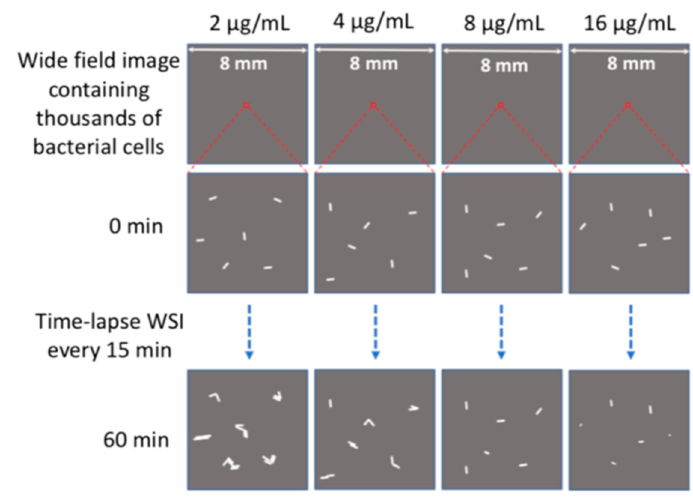
Figure 2. Number-based distribution of normalized single-cell growth rate for several thousand E. cloacae cells treated with 2, 4, 8 and 16 µg/mL of gentamicin.